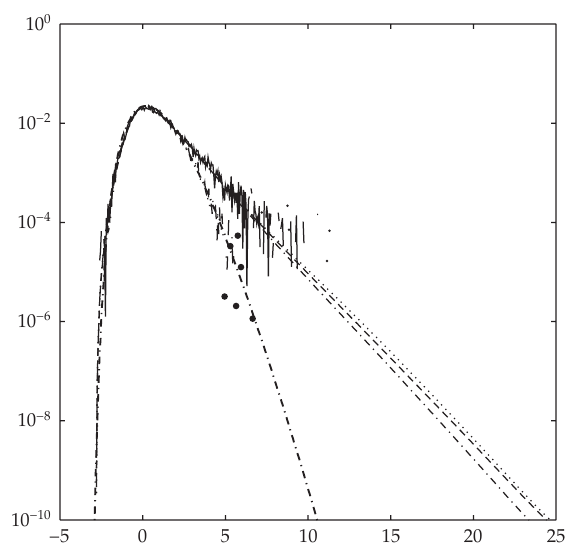
(cid:2) u (cid:3) using the N